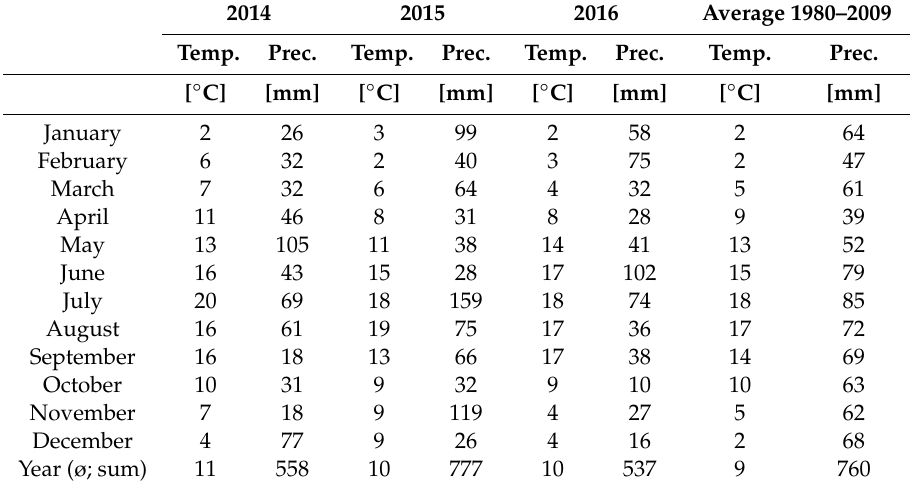
Table 1. Monthly temperature and precipitation in 2014, 2015, 2016, and long-term average. Data from the three sites were averaged as they did not di ff er significantly from each other.